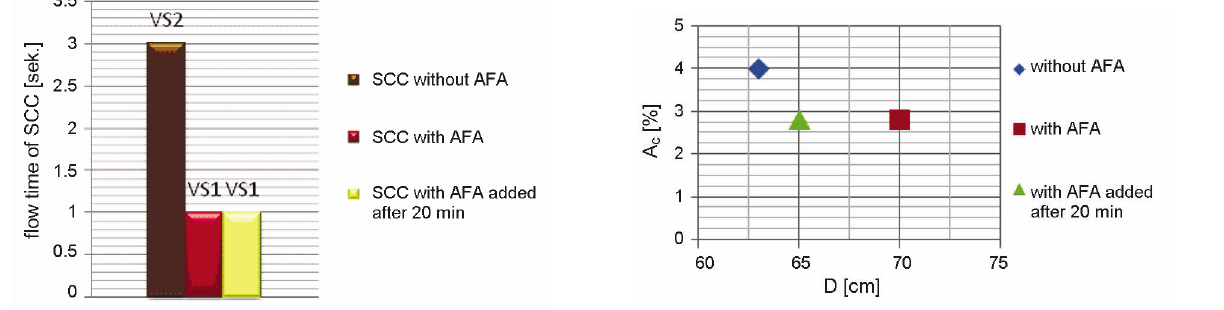
Fig. 9. The influence of AFA and the time of its introduction on flow time of SCC. Symbols VS1 and VS2 represent viscosity classes according to Table 2